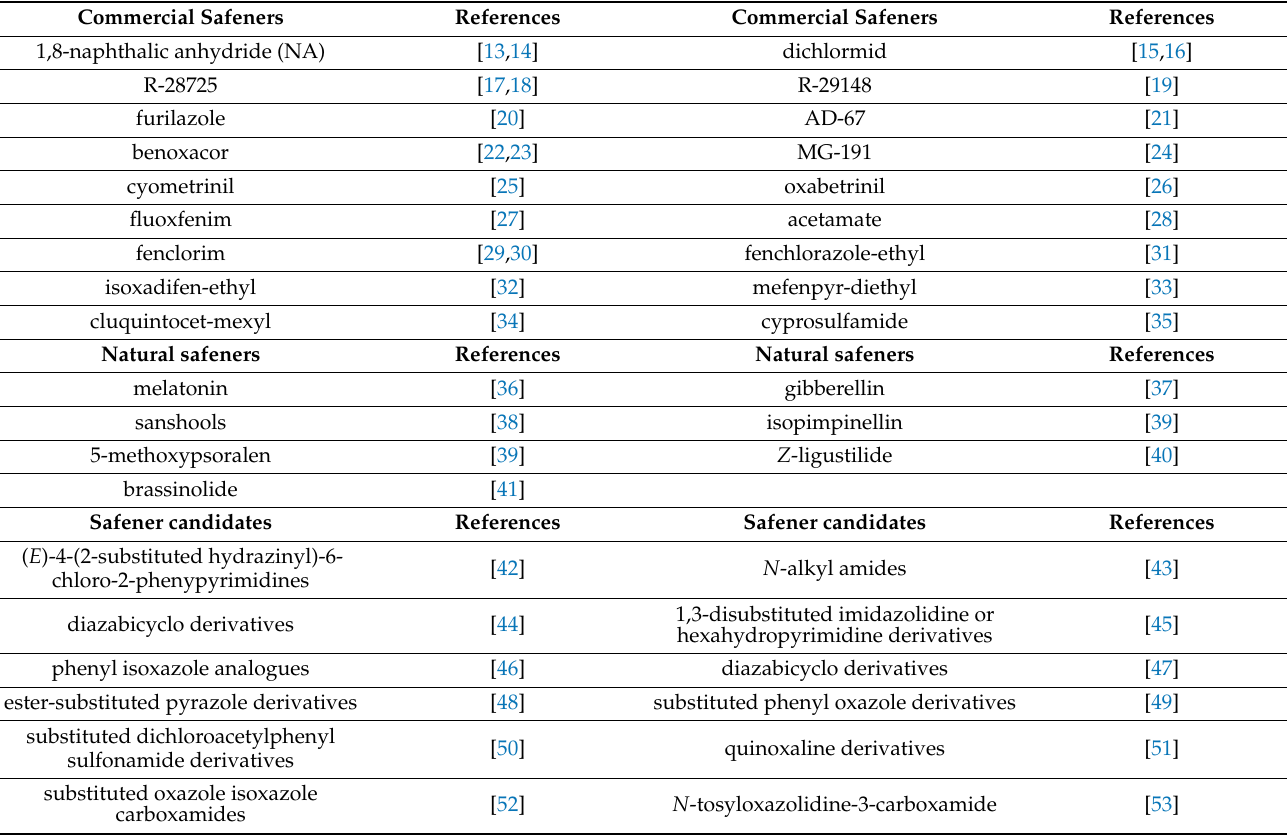
Table 1. Recent commercial safeners and some safener candidates induced enhancement of GST